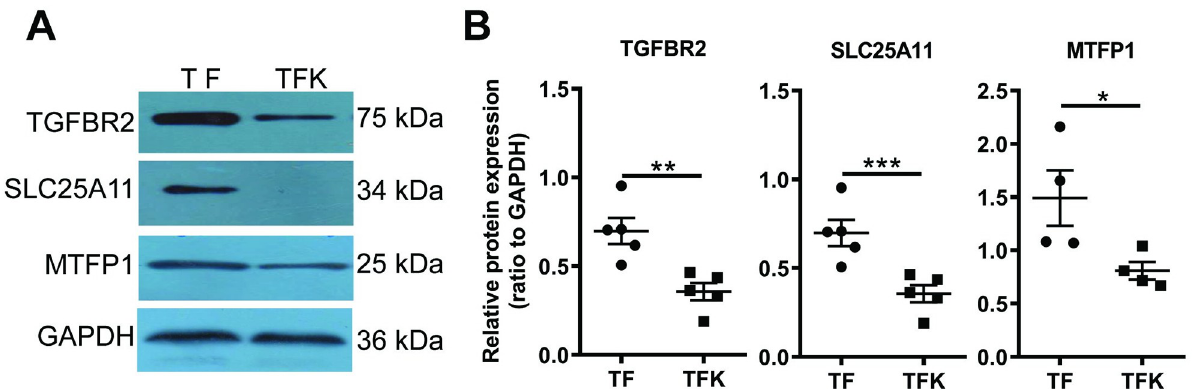
Fig 7. Western blot validation of differential expression of TGFBR2, SLC25A11, and MTFP1. (A) Western blot results showing the expression levels of TGFBR2, SLC25A11, and MTFP1 in TF and TFK mice. GAPDH was used as an internal control. (B) Statistical analysis on the semi- quantification data of bands. Each dot or square represents one replicate. � : p < 0.05, �� : p < 0.01, ��� : p < 0.001.